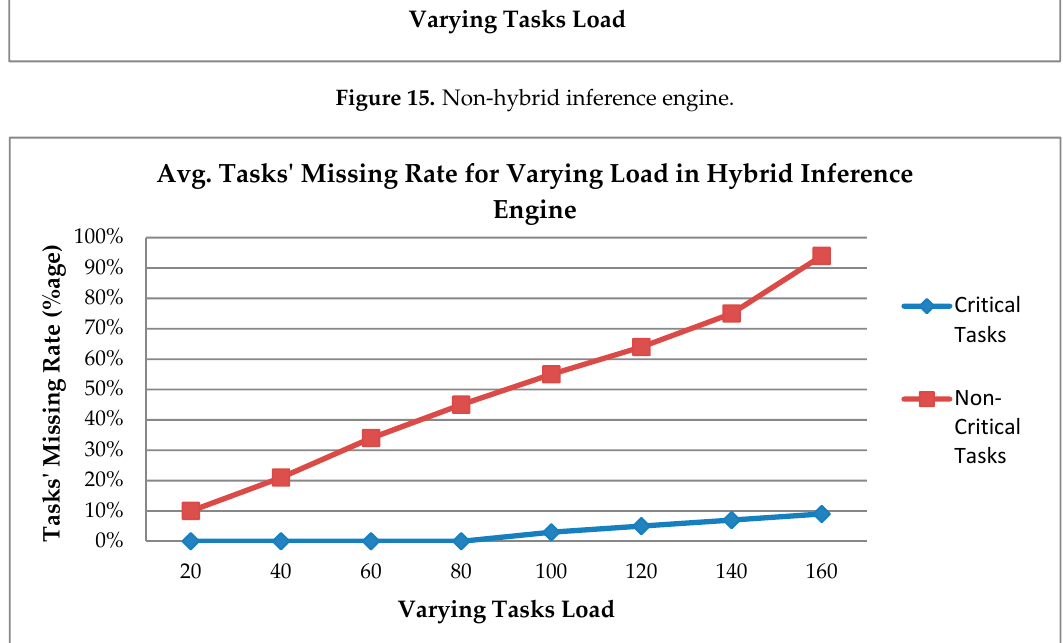
Figure 16. Hybrid inference engine.